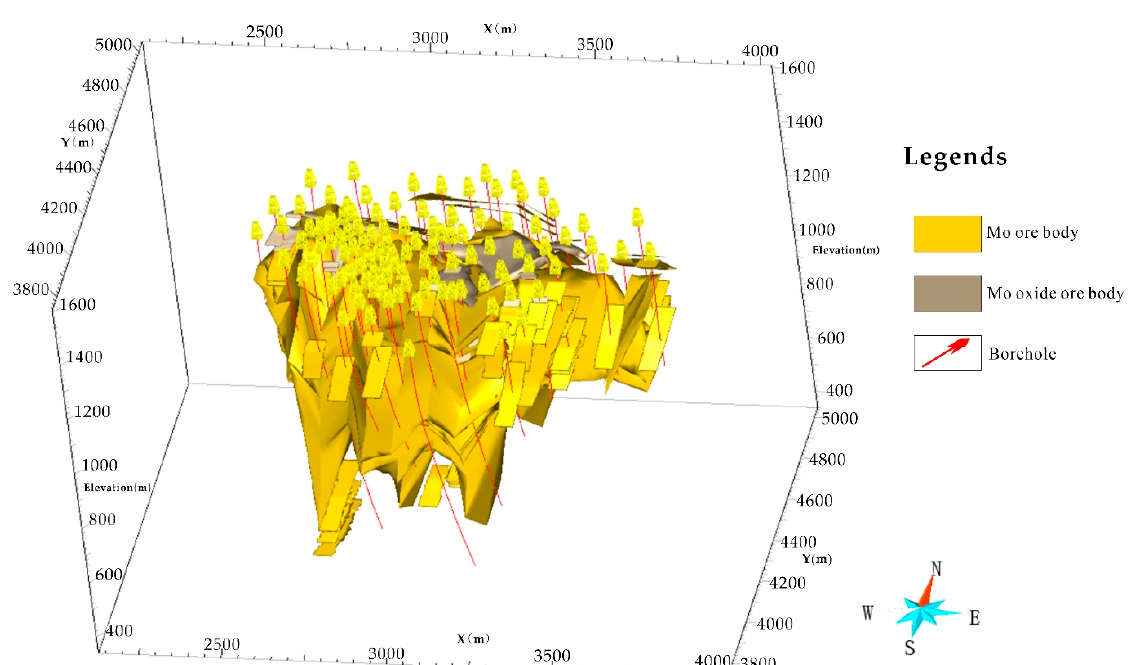
Figure 6. Spatial relationship between rich orebody and main faults (superposition of main faults with ore shoot).